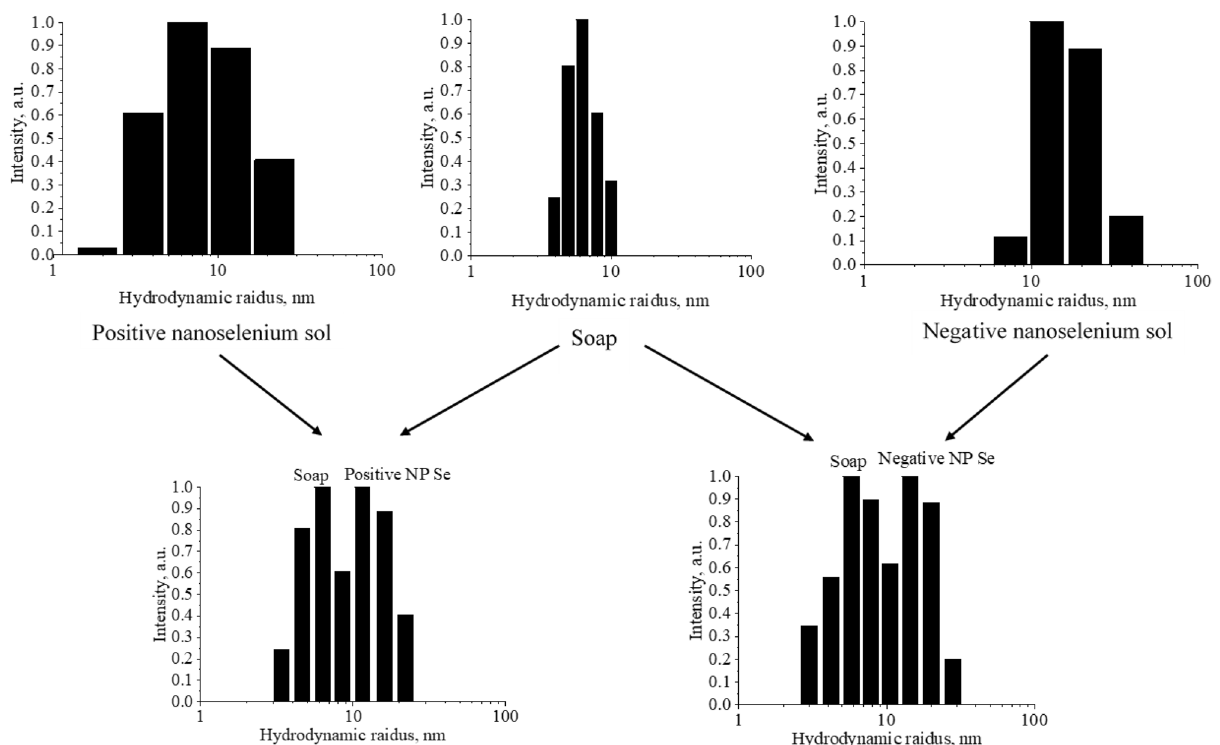
Figure 21. The distribution of hydrodynamic radii of particles in experimental samples of liquid soap.